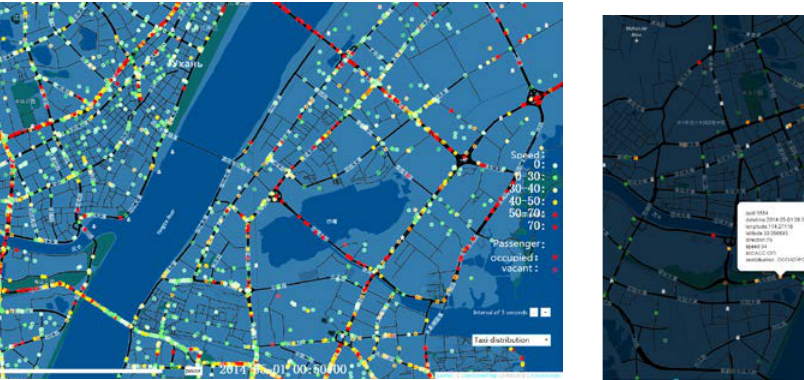
Figure 8. Taxi distribution at 00:50:00 on May 1.